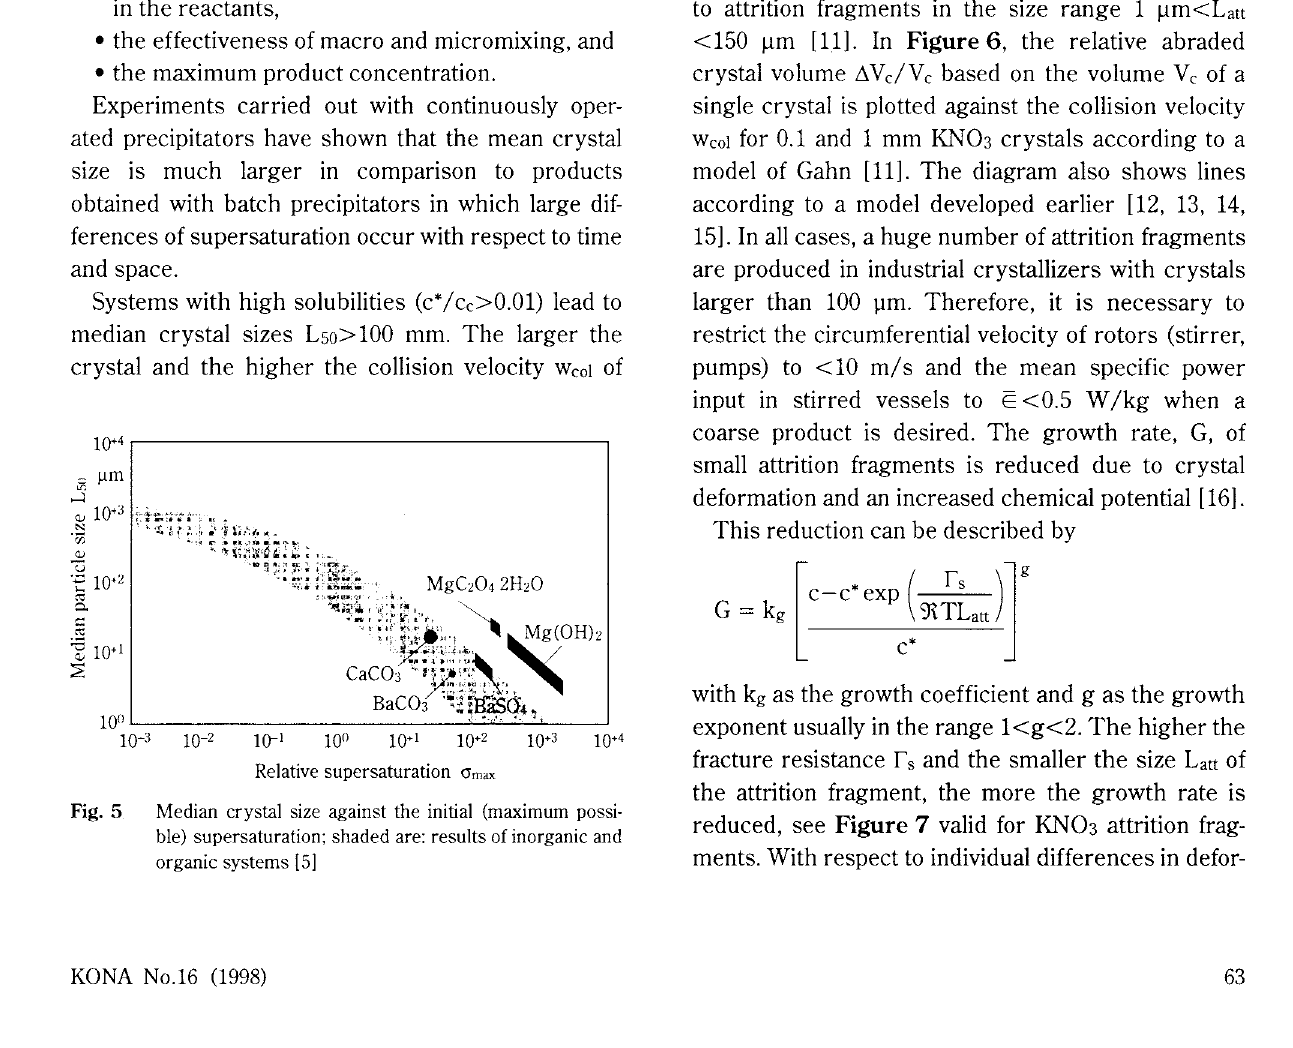
Fig. 6 Relative attrition volume against the collision velocity (crystal resistance) for KN0:1 according to different models crystals against a resistance (rotor, wall, other crys tals), the stronger are the attrition effects which lead to attrition fragments in the size range 1 J.tm<Latt <150 J.tm [11]. In Figure 6, the relative